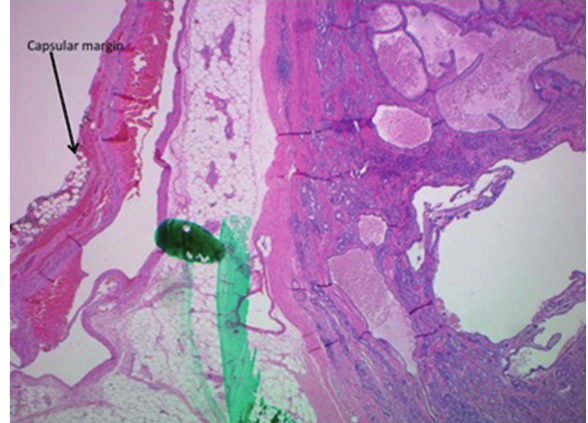
Figure 6 - Capsular margin seen at radical prostatectomy - Distance from capsule to malignant cells